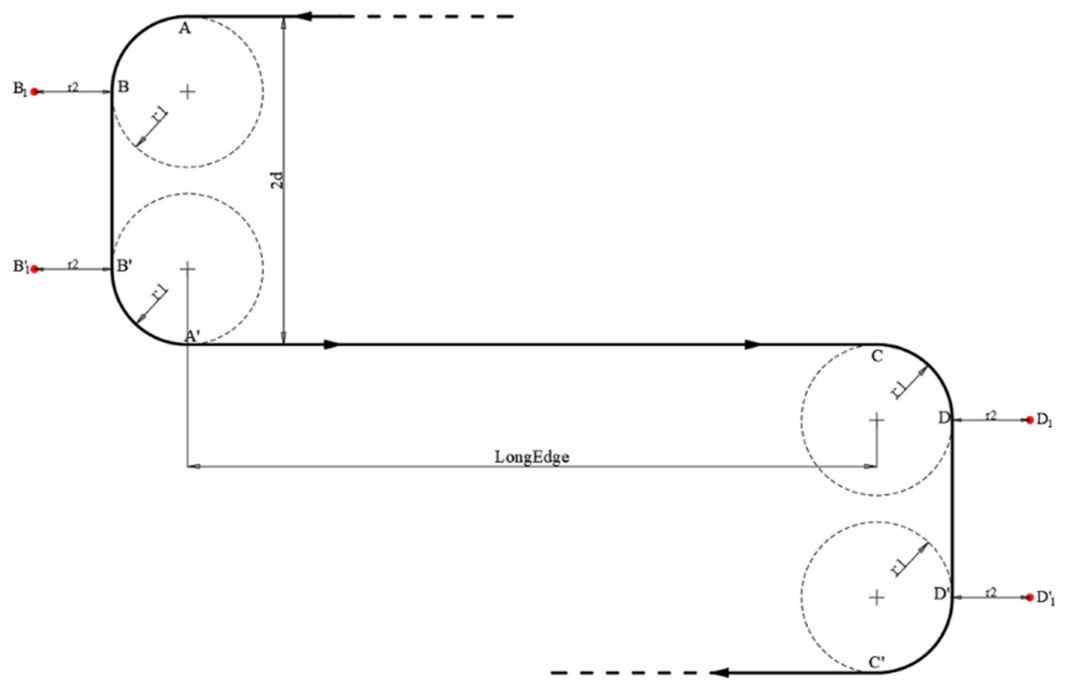
Figure 10. Dubins path (LSL + RSR) when d ≥ R for one